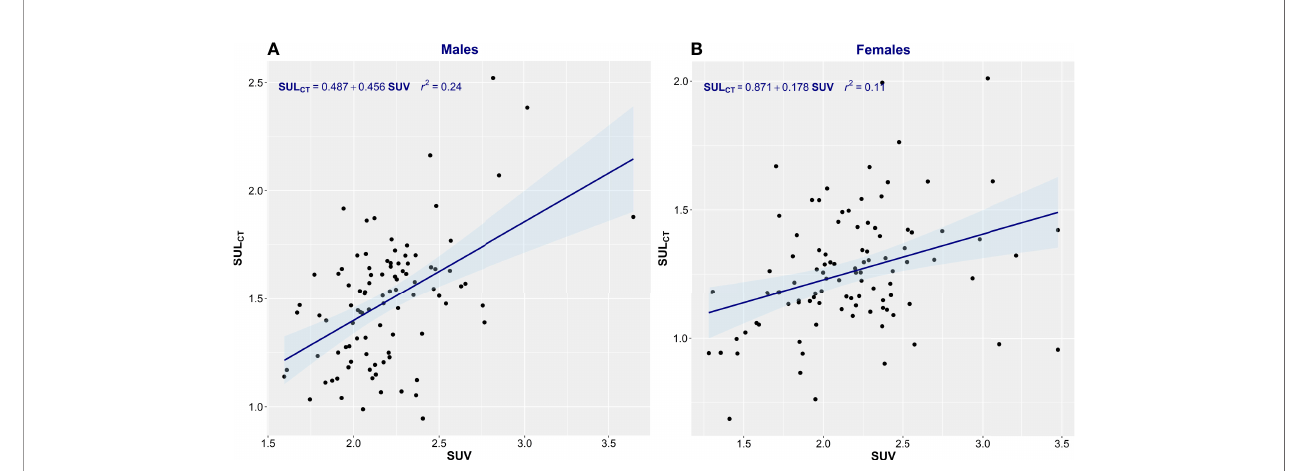
FIGURE 2 | Scatter plot of standardized uptake value (SUV) vs. standardized uptake adjusted by lean body mass (SUL CT ). Men (A) and Women (B) . The linear regression equation is provided in the top left of each graph, and it is plotted in blue. The shaded light-blue area represents the 95% con fi dence interval, and r 2 is the square of the Pearson correlation coef fi cient for SUV vs. SUL CT .